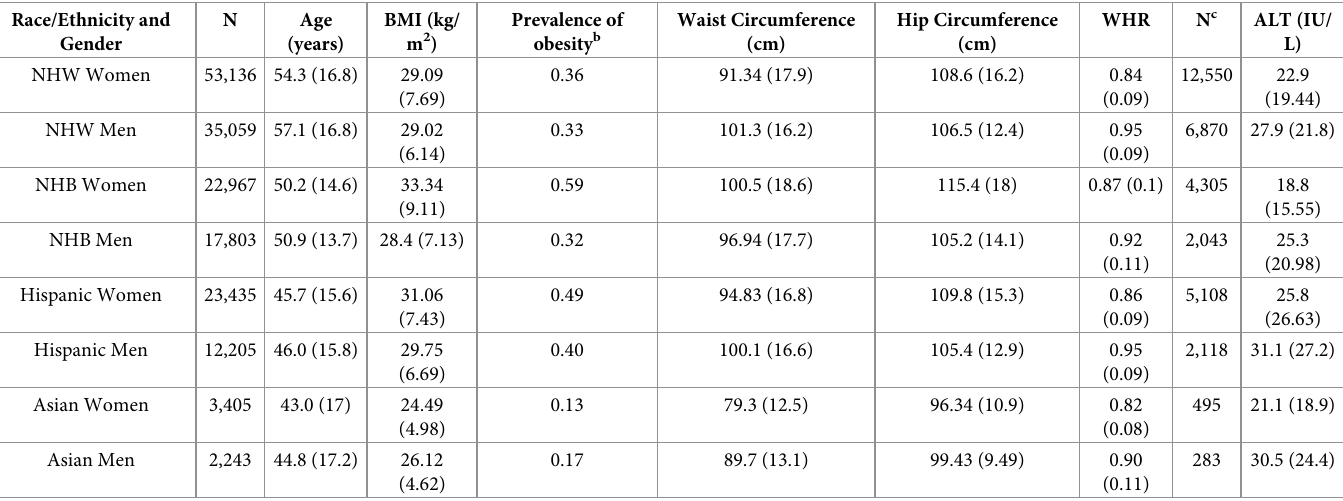
Table 1. Characteristics of age, anthropometric traits and ALT levels by race/ethnicity and gender a . Race/Ethnicity and